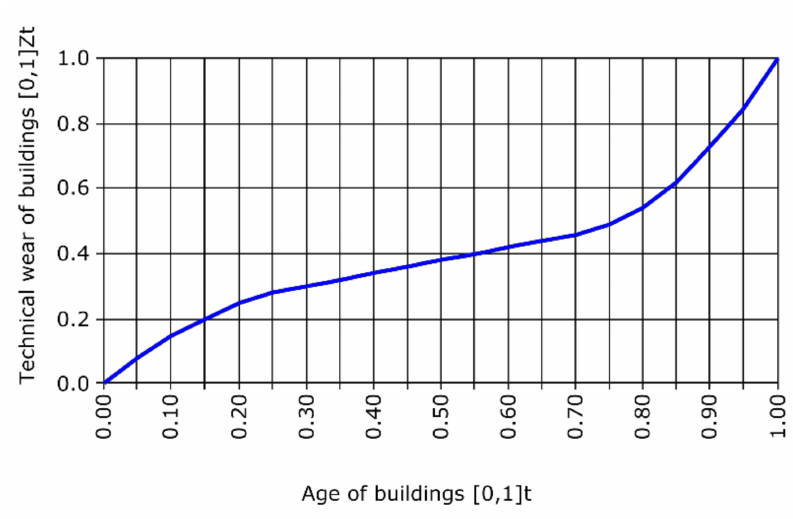
Figure 1. A typical course of the wear process of residential buildings during their